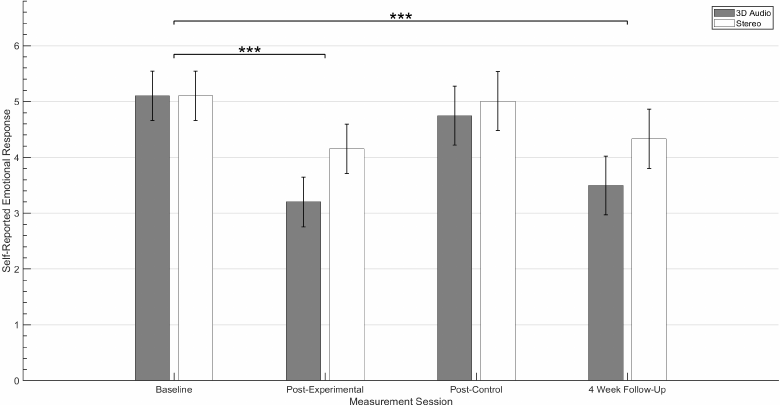
Figure 4. Mean self-reported emotional response to target stimuli for both experimental conditions. Whiskers denotes ±95% confidence intervals. p values (*** p value < 0.001) were determined from post hoc pairwise comparison test and are indicated above the